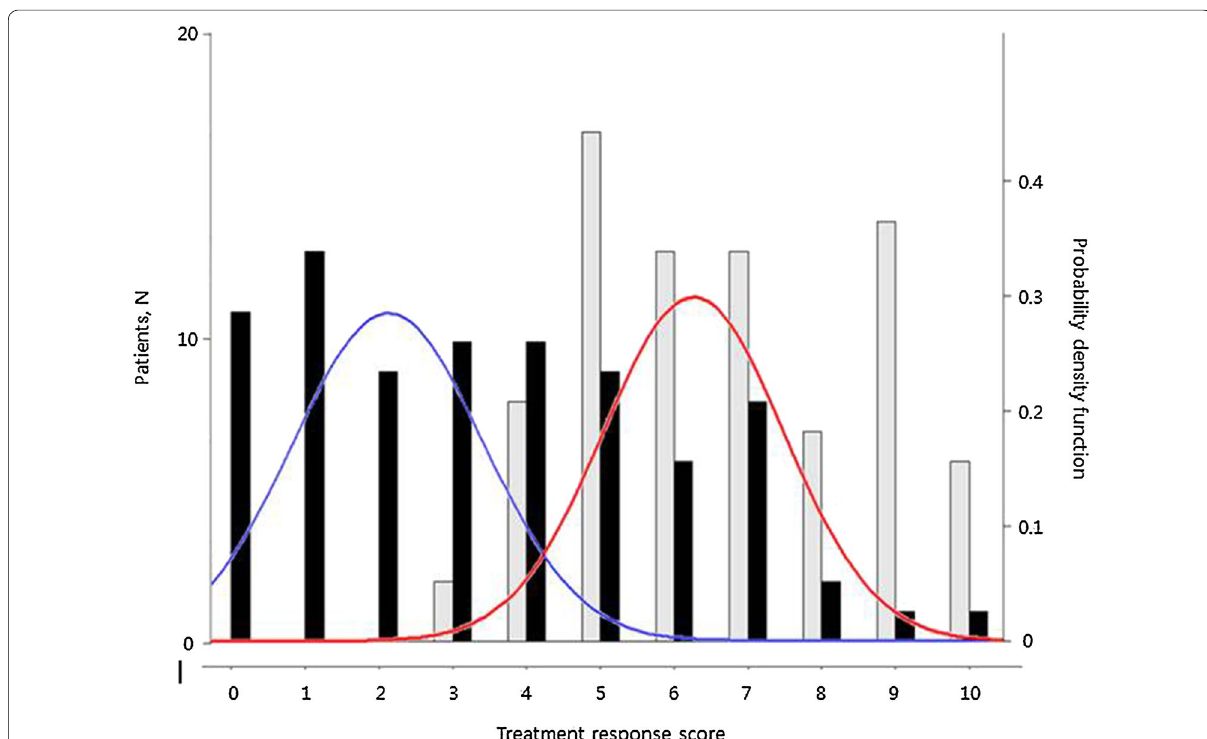
Fig. 2 Empirical and theoretical distributions of the treatment response score. This figure shows a histogram of total score ( black ) and A score ( gray ) with two density plots of the total score for the two subpopulations. The subpopulations indicate good responders ( red ) and moderate/poor responders ( blue ) as assessed by total Alda scale scores identified by the Bayesian minimum message length